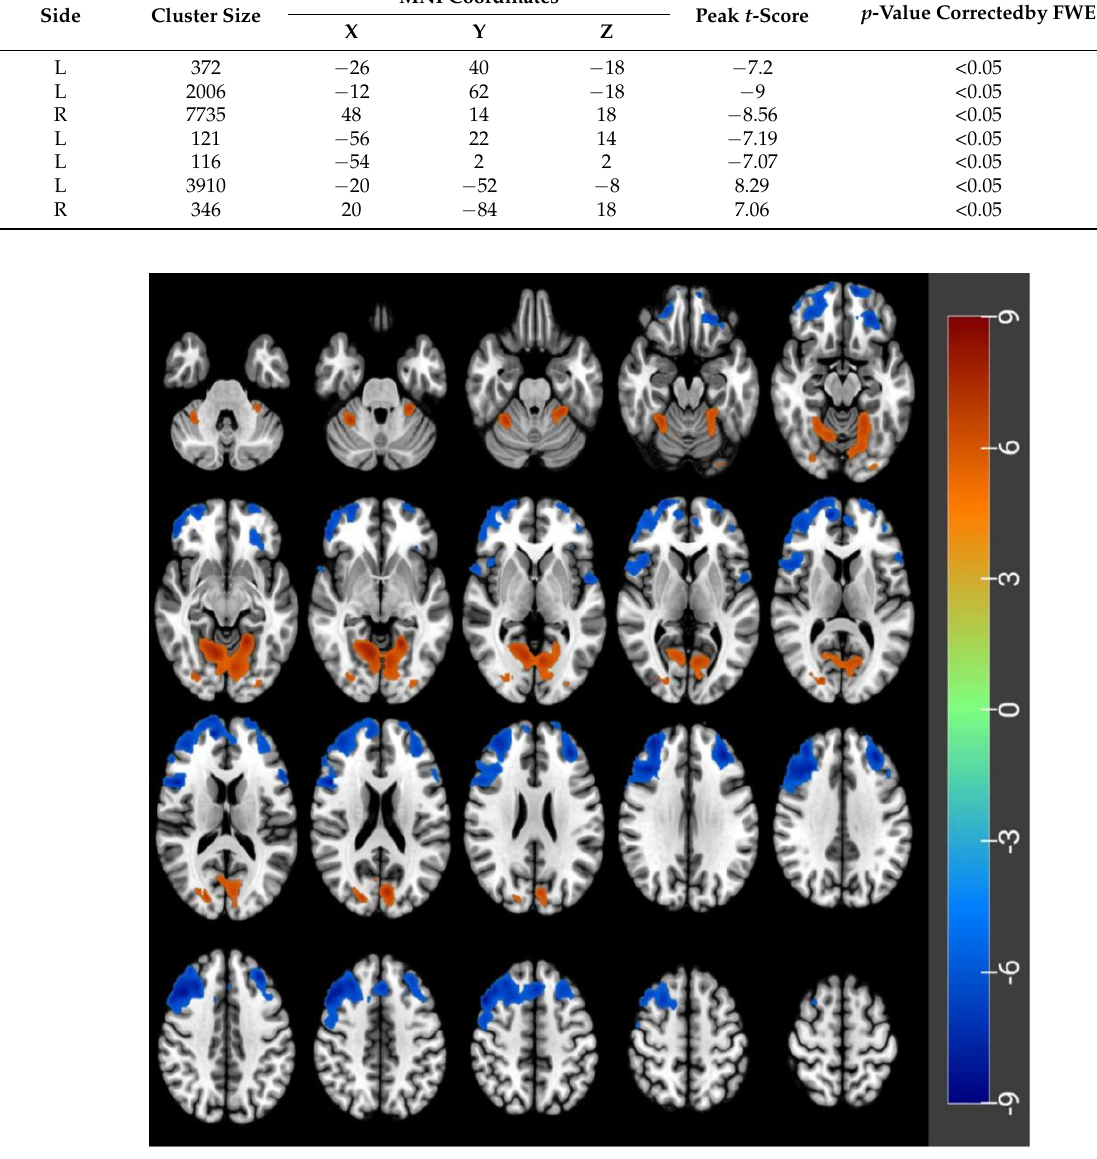
Figure 3. CBF differences before and after acute SD (paired t -tests, voxel-level FWE, p < 0.05). Hy- poperfusion in the Frontal_Mid_Orb_L, Frontal_Inf_Oper_R, Frontal_Sup_Orb_L, Rolandic_Oper_L and Frontal_Inf_Tri_L. Hyperperfusion in the Lingual_L and Occipital_Sup_R. 3.3. GMV Differences before and after Acute SD Statistical plots of GMV in subjects ( n = 29) were imported into Xjview software. There were no significant red or blue stained areas in the statistical actions after 36 h of SD, compared to the RW state, suggesting no significant increase or decrease in GMV (paired t -test, p < 0.05 for voxel level FWE), as shown in Figure 4.